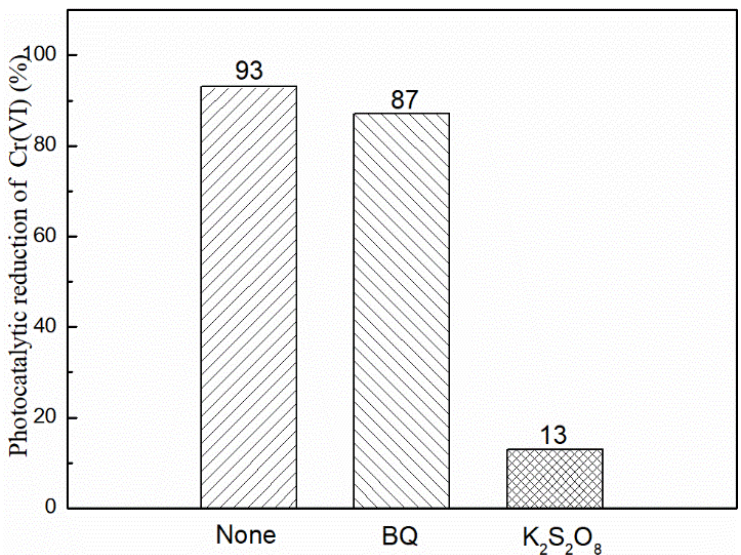
Figure 6. Photocatalytic reduction of Cr(VI) experiments with the addition of radical scavenger.